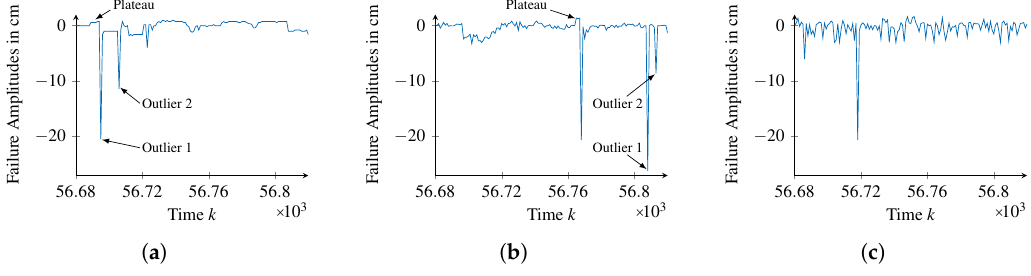
Figure 13. Comparing 140 time steps of failure amplitudes from the Sharp GP2D12 sensor, the generic failure model, and the neural network. ( a ) validation data; ( b ) generic failure model; ( c ) neural